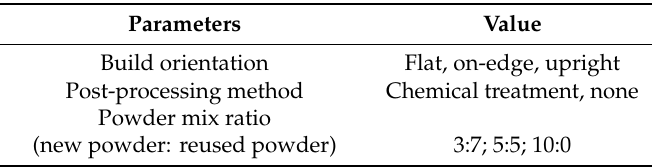
Table 2. Processing parameters used in this study.